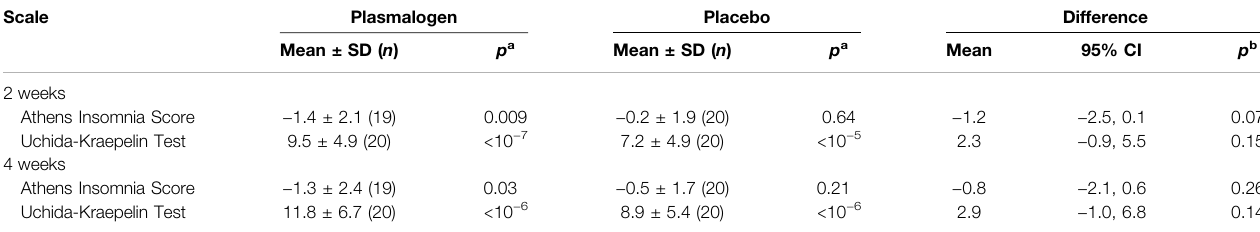
TABLE 5 | Changes from baseline in Athens Insomnia Score and Uchida-Kraepelin Test (achievement percentage) at 2 and 4 weeks. Scale